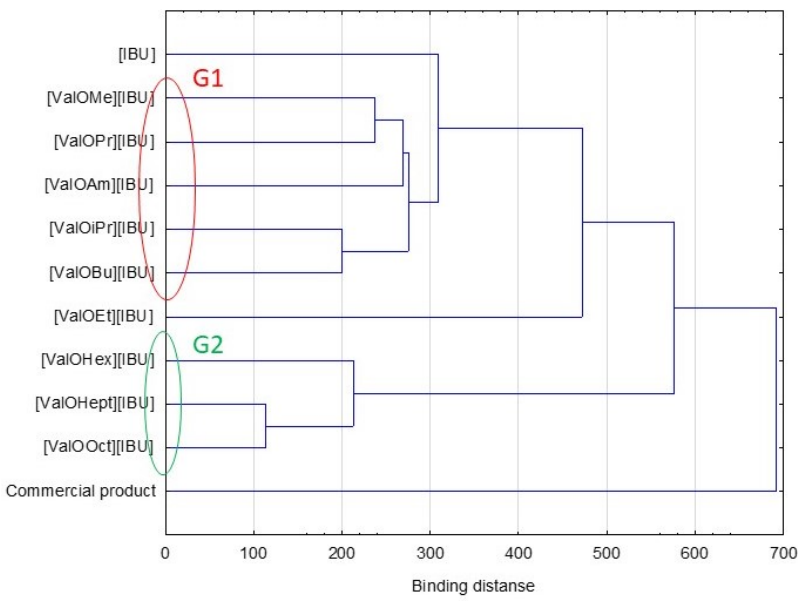
Figure 3. Cluster analysis plot for mean cumulative mass for [IBU] and its derivatives permeated through human skin and Strat-M™ from hydrogel preparations.